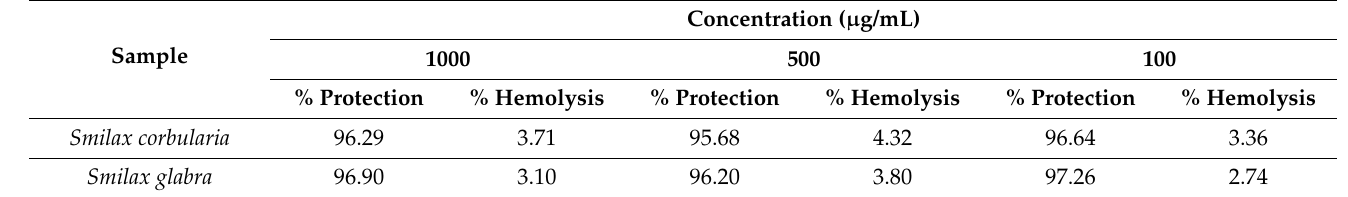
Table 6. Anti-inflammatory effects of the ethanolic extracts of Smilax glabra and Smilax corbularia .